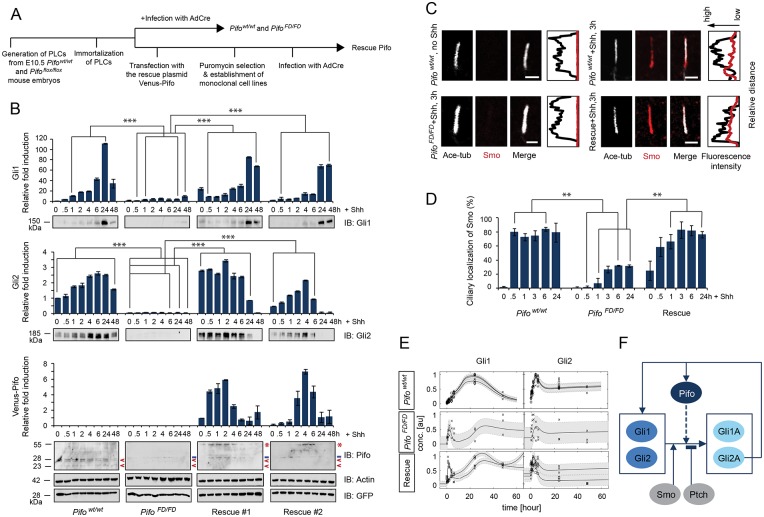
Pifo is necessary and sufficient for ciliary localization of Smo and Shh target gene activation.(A) Experimental scheme for generating Pifo conditional knock-out and Venus-Pifo rescued cell lines. (B) Induction kinetics of Gli1 and Gli2 protein in Pifowt/wt, PifoFD/FD, and two independent Venus-Pifo rescued PLC cell lines upon Shh stimulation. Note that expression levels of the endogenous (<) and Venus-tagged Pifo (*) were detected by α-Pifo (- indicates non-specific bands). Protein loading was controlled by Actin levels. Transduction efficiency of AdCre was evaluated by α-GFP. Mean ± SD of three independent experiments. Representative confocal image (C) and quantification (D) of ciliary Smo in Pifowt/wt, PifoFD/FD, and rescued PLCs. Scale bar = 2 μm. >100 cilia per condition were analyzed. All error bars indicate the mean ± SD of three independent experiments. Data were analyzed using a two tailed unpaired t-test (** = p<0.01, *** = p<0.001). (E) The fitted Pifo+ model dynamics (solid line) of Gli1 and 2 for the three different conditions (Pifowt/wt, PifoFD/FD and Rescue) relative to Shh activation (t = 0). Black circles, boxes and crosses denote experimental data in replicates, arbitrary units. Gray areas denote the confidence intervals for the parameter estimation. (F) Scheme showing hypothesized influence of Pifo on Shh target genes, Gli1 and 2, (dotted line) used for the mathematical model. Smo and Pifo support activation of Gli1 and 2, but Ptch inhibits the activation. Activated Gli1 and 2 (Gli1A and Gli2A) support both their own and Pifo expression levels.